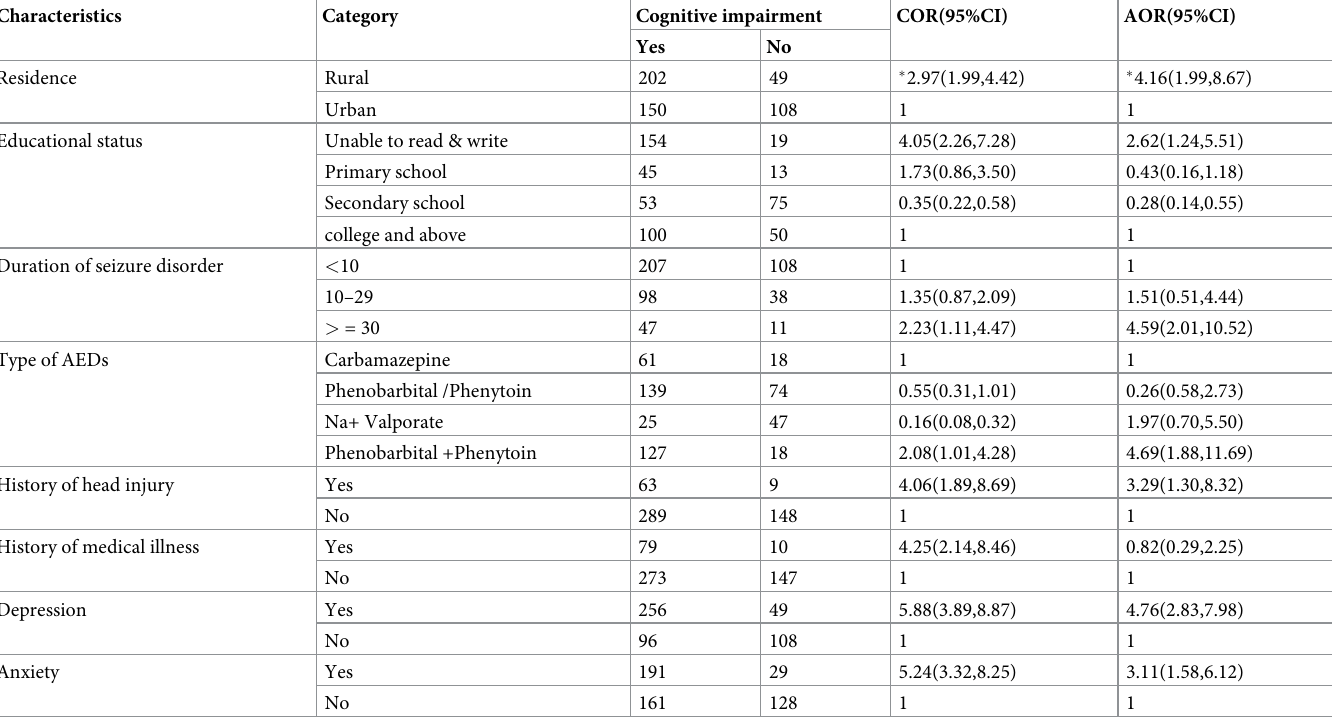
Table 3. Factors associated with cognitive impairment among patients with epilepsy attending outpatient department of South Gondar hospitals 2020(n = 509).